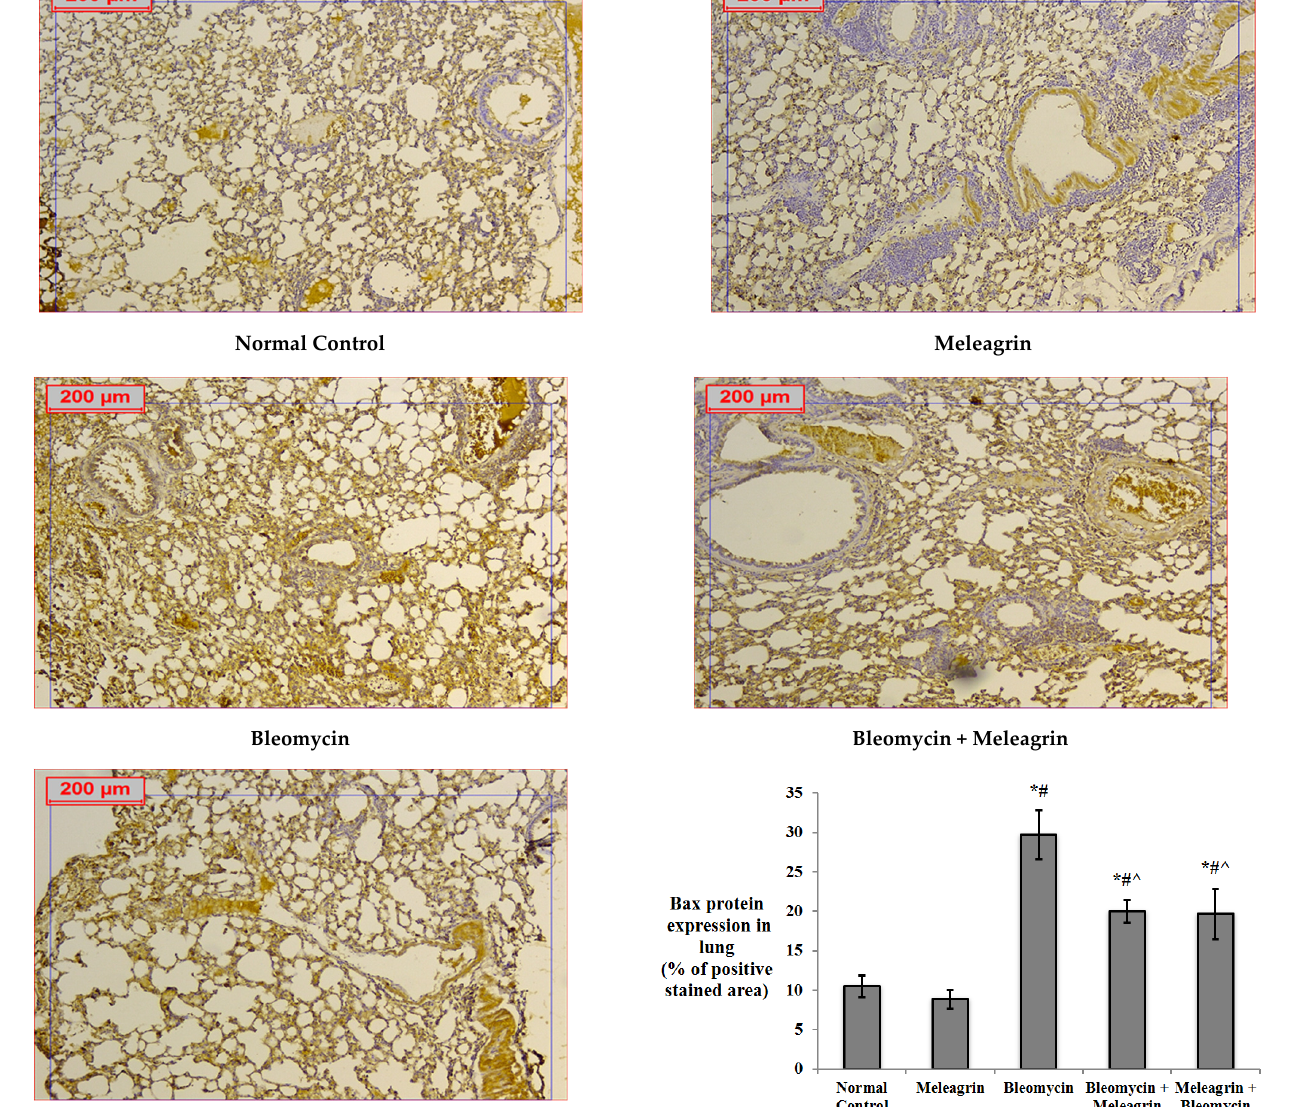
Figure 7. The effect of meleagrin on the protein expression levels of Bax in the lung tissue of the experimental mice determined by immunohistochemistry. Bax = B cell lymphoma-2 associated X protein. Data of the percentage of positive stained area are expressed as mean ± SD and analyzed using one-way ANOVA followed by Bonferroni’s post hoc test ( n = 8). * significantly different vs. the normal control group; # significantly different vs. the meleagrin group; ^ significantly different vs. the bleomycin group. Differences were considered significant at p < 0.05.